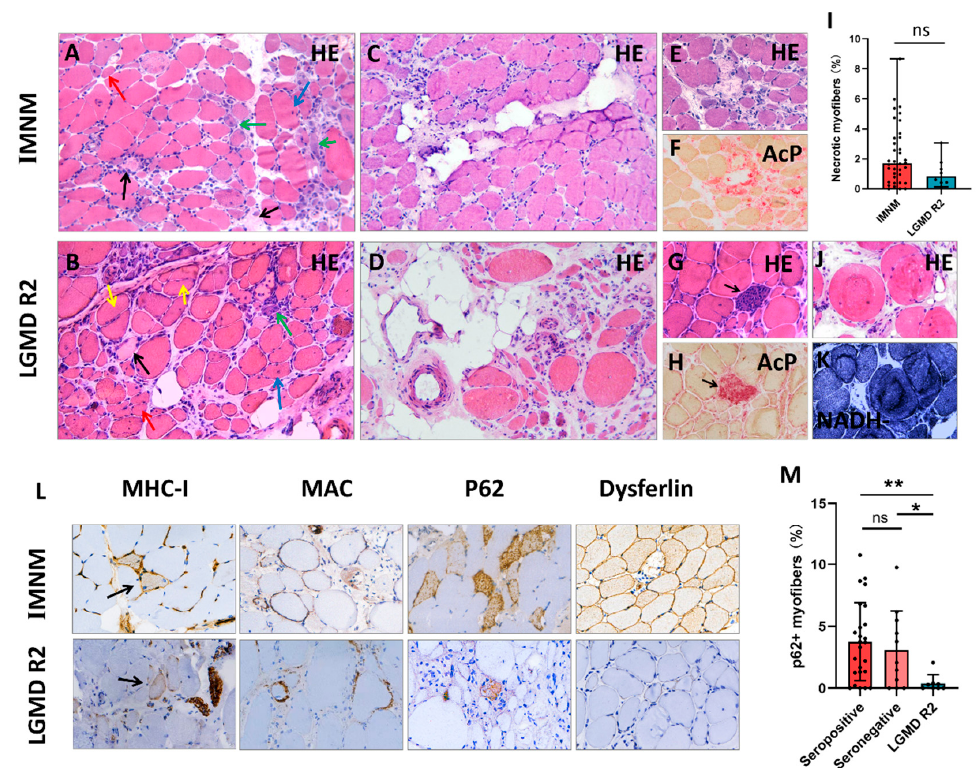
Figure 2. Representative histopathological images of IMNM and LGMD R2. ( A , B ) Hematoxylin- eosin (H&E) staining showing profound necrotic myofibers (black arrows), regenerating myofibers (basophilic cells, green arrows), degenerating myofibers (myofibers with internalized nuclei, blue arrows), atrophic myofibers (red arrows), and splitting myofibers (yellow arrows). ( C ) Slight fat replacement in an IMNM biopsy. ( D ) Severe fat replacement with fiber size variability (dramatically atrophic or enlarged myofibers) in an LGMD R2 patient with a long course of disease. ( E – H ) H&E and acid phosphatase (AcP) staining showing necrotic myofibers undergoing myophagocytosis. ( I ) More necrotic myofibers in IMNM biopsies. ( J , K ) H&E and NADH staining showing ring/whorled myofibers in a LGMD R2 biopsy. ( L ) Immunohistochemical staining for major histocompatibility complex class I (MHC-I, black arrows), membrane attack complex (MAC), sequestosome 1 (p62), and dysferlin. ( M ) More myofibers positive for p62 in seropositive and seronegative IMNM biopsies. Images ( A – D ): original magnification 200 × ; images ( E – H , J – L ): original magnification 400 × . ns, no significance; * p < 0.05, ** p <